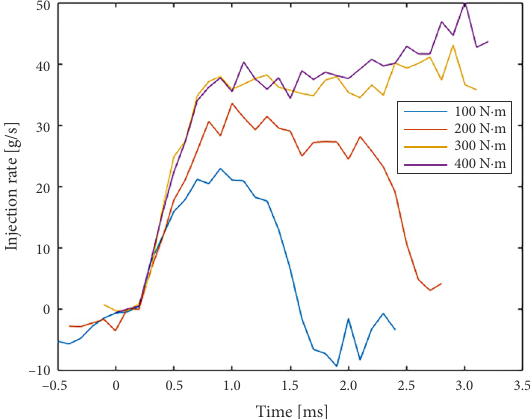
Figure 11. Measured injection rates of the four engine operating points with 0° plug valve position, 6 MPa